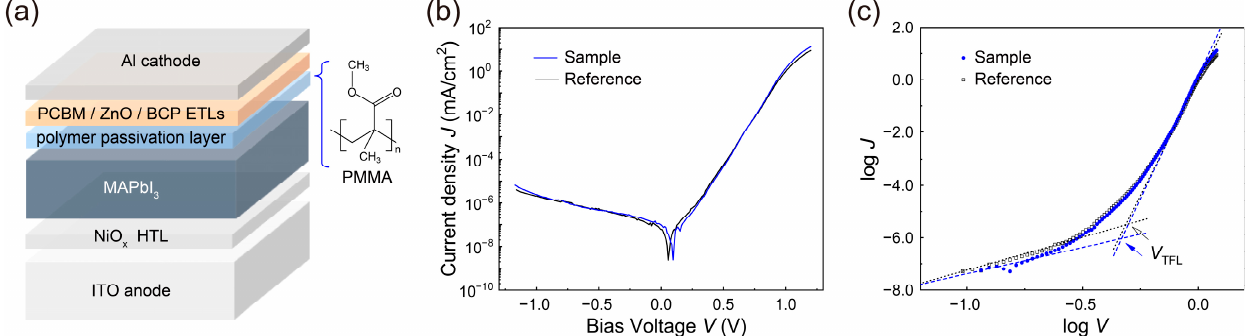
Figure 2. ( a ) Schematic device configuration of a MAPbI 3 photodiode with a cathode-side PMMA passivation layer. Dark-current density-voltage ( J dark - V ) characteristics of MAPbI 3 photodiodes without (reference) and with a cathode-side PMMA passivation layer (sample) on ( b ) a semi-log scale and ( c ) a log–log scale.